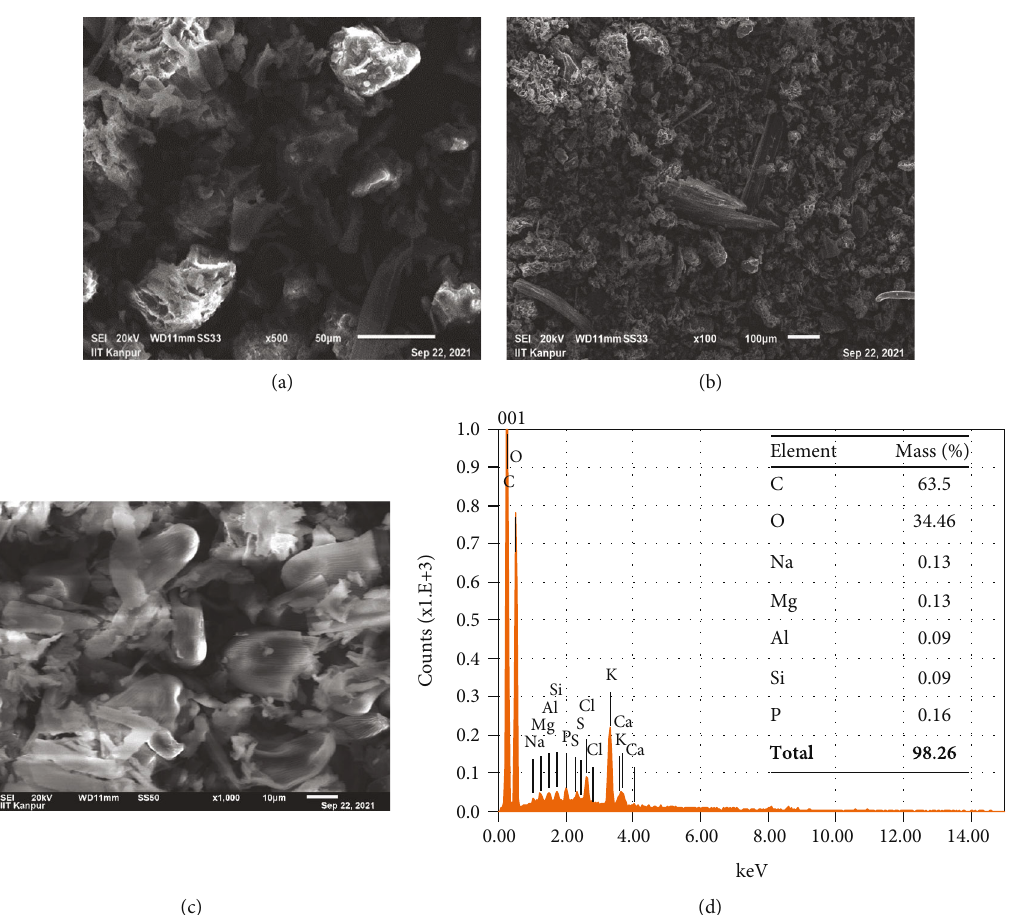
Figure 5: FESEM micrographs of marigold fl owers (a, b), EDS spot (c), and EDS spectra